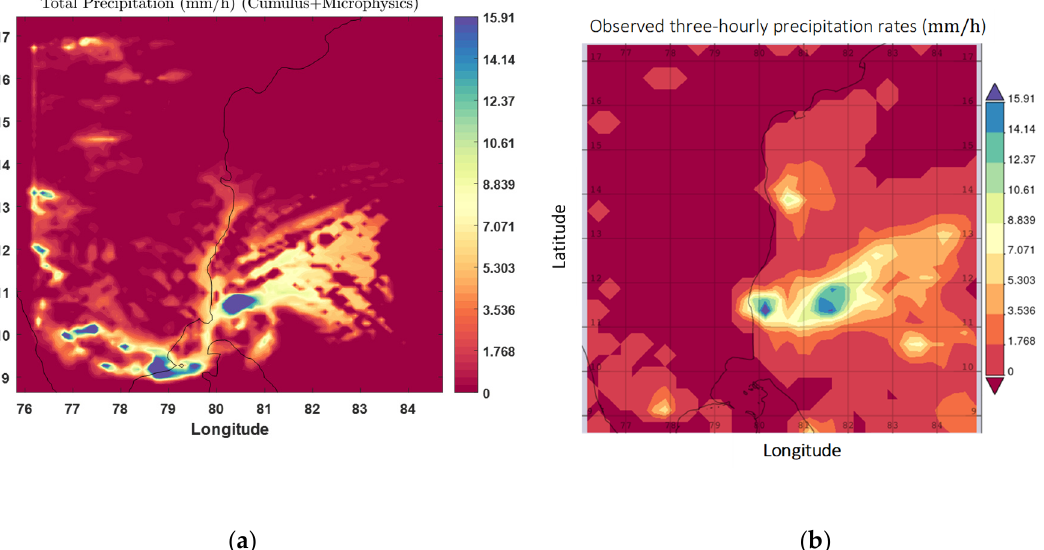
Figure 2. Precipitation rates: ( a ) modelled total precipitation rate (mm/h) from WRF’s WDM6 microphysical scheme; ( b ) observed three-hourly TRMM (Tropical Rainfall Measuring Mission) precipitation rates (mm/h) for 2 December 2015 12:00:00-15:00:00 (1730-2030 IST) (URL: https://disc.gsfc.nasa.gov/datasets/TRMM_3B42_7/summaryTRMM2011, accessed on 15 December 2021).